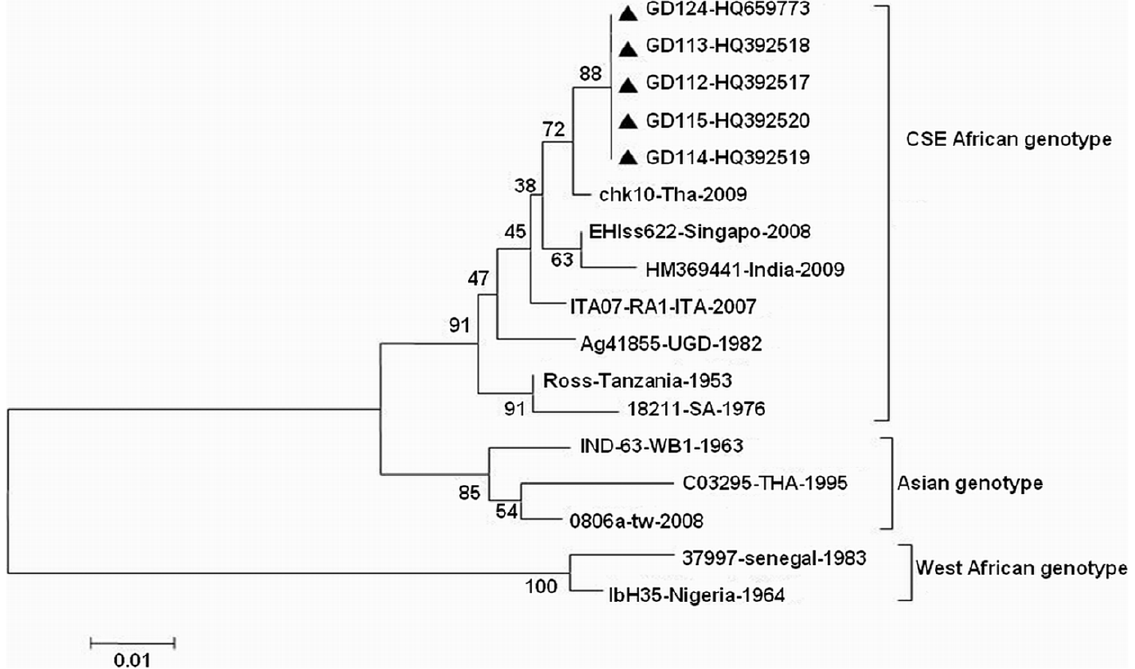
Figure 3. Phylogenetic dendrogram of 5 Dongguan CHIKV strains. This dendrogram was constructed using the neighbor-joining method based on the alignment of E1 gene sequences. The bootstrap values from 1000 pseudoreplicates for major lineages within the tree are shown as percentages. Dongguan CHIKV strains are marked using the symbol m . doi:10.1371/journal.pone.0042830.g003 PLOS ONE |